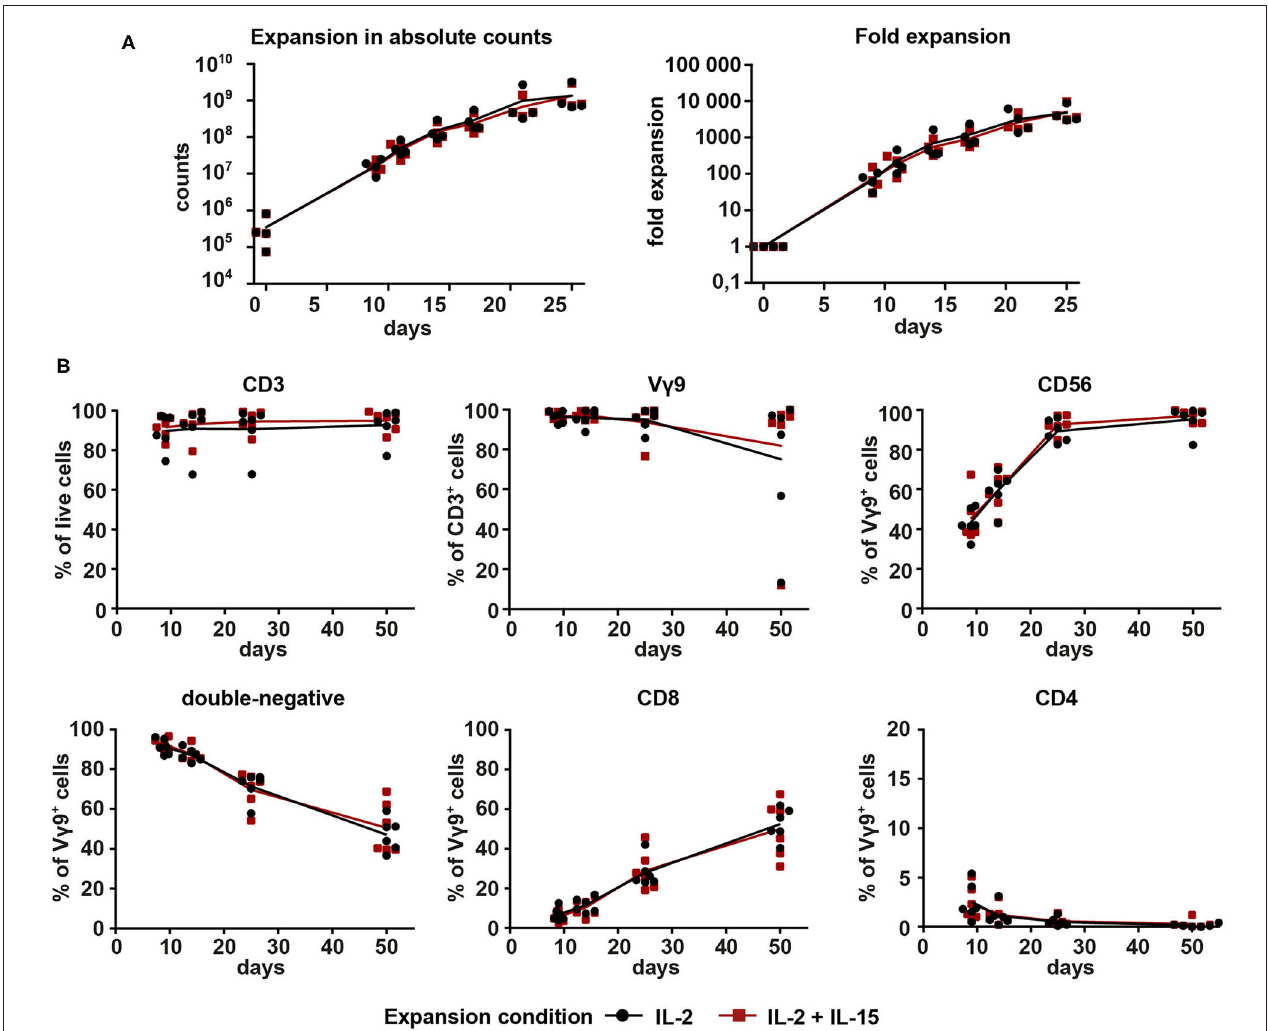
FIGURE 1 | Proliferation and purity analysis of V γ 9V δ 2T cells expanded with IL-2 (1,000 U/ml) or combined IL-2 (100 U/ml) + IL-15 (100 U/ml). V γ 9V δ 2T cells were expanded with 10 µ M ZOL and either (a) 1000 U/ml IL-2 (black) or (b) 100 U/ml IL-2 + 100 U/ml IL-15 (red). (A) Total cell count of V γ 9V δ 2T cell cultures expanded from PBMCs ( n = 4, compiled from three independent experiments; γδ HD1–4) for 25 days. Fold expansion was calculated based on the number of V γ 9 + cells initially present in the culture. (B) V γ 9V δ 2T cell cultures expanded from PBMCs ( n = 6, compiled from three independent experiments; γδ HD5–10) for 50 days were analyzed by flow cytometry for expression of CD3, V γ 9, CD56, CD4, and CD8 on days 9, 14, 25, and 50 of culture. Lymphocytes were gated first, and then doublets were excluded before gating on live cells. Lines represent means of all